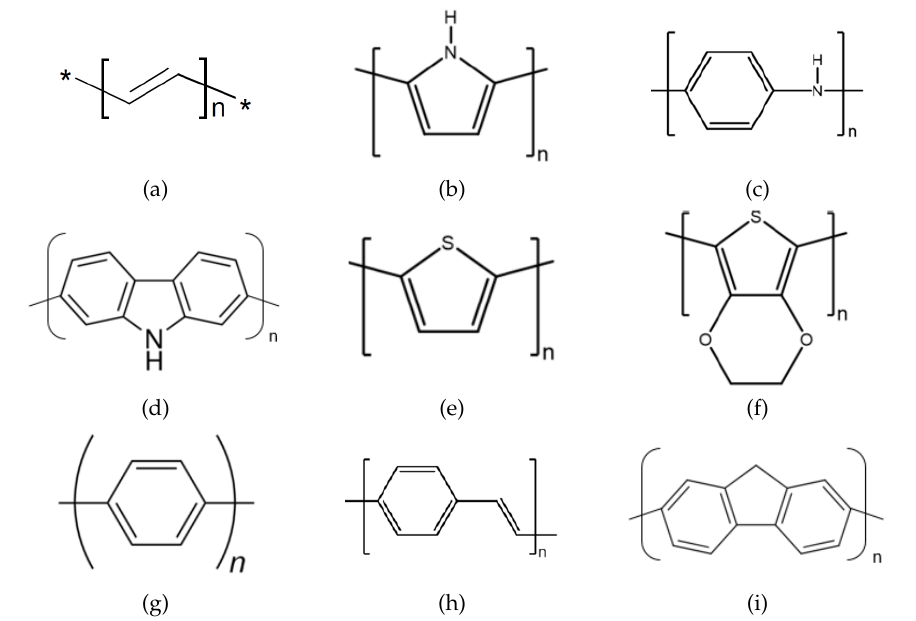
Table 1. Chemical structures of some common conducting polymers: (a) polyacetylene, (b) polypyrrole, (c) polyaniline, (d) polycarbazole, (e) polythiophenes, (f) poly(3,4-ethylenedioxythiophene), (g) polyphenylenes, (h) poly(phenylene vinylene), (i) polyfluorene.